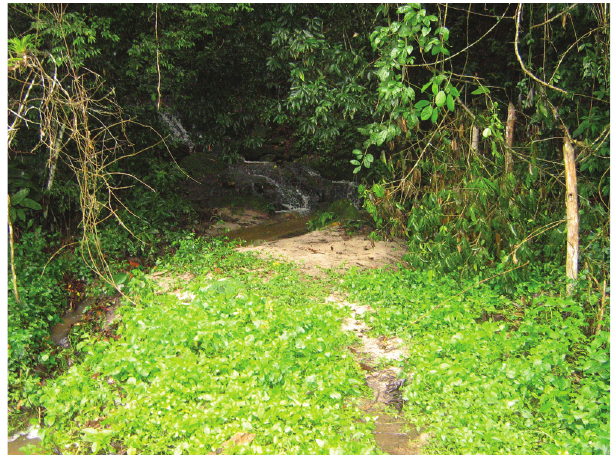
Fig. 7. Photograph of small stream tributary to rio Itariri, itself tributary to rio Juquiá, rio Ribeira de Iguape basin, 24°15’06.4”S 47º14’53.3”W, locality of the newly-discovered population of Listrura camposi